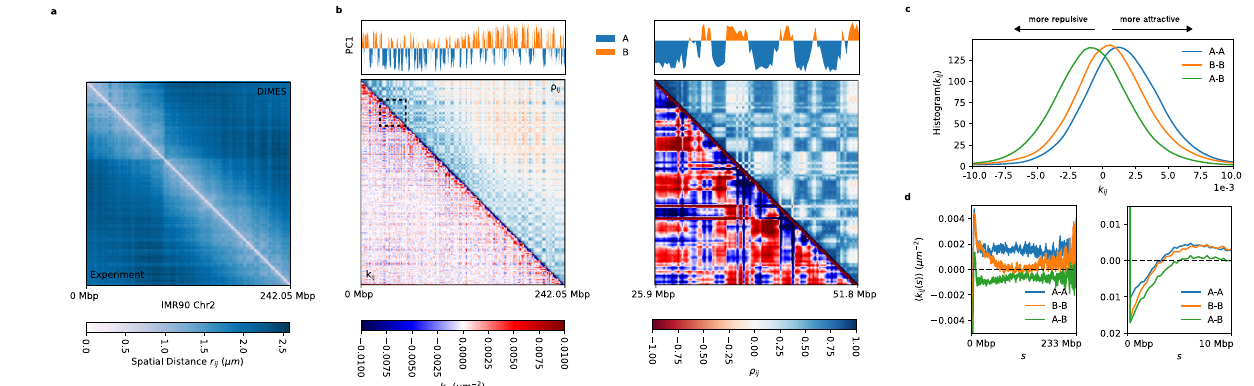
Fig.7|FeaturesoftheChr2organization.a Theaveragedistancematrixbetween the experiment (lower triangle) and the DIMES (upper triangle) shows excellent agreement. b The connectivity matrix K , whose elements are k ij (lower triangle), and the correlation matrix ρ (upper triangle) computed from K . The top track shows the principal component dimension 1 (PC1) computed using principal